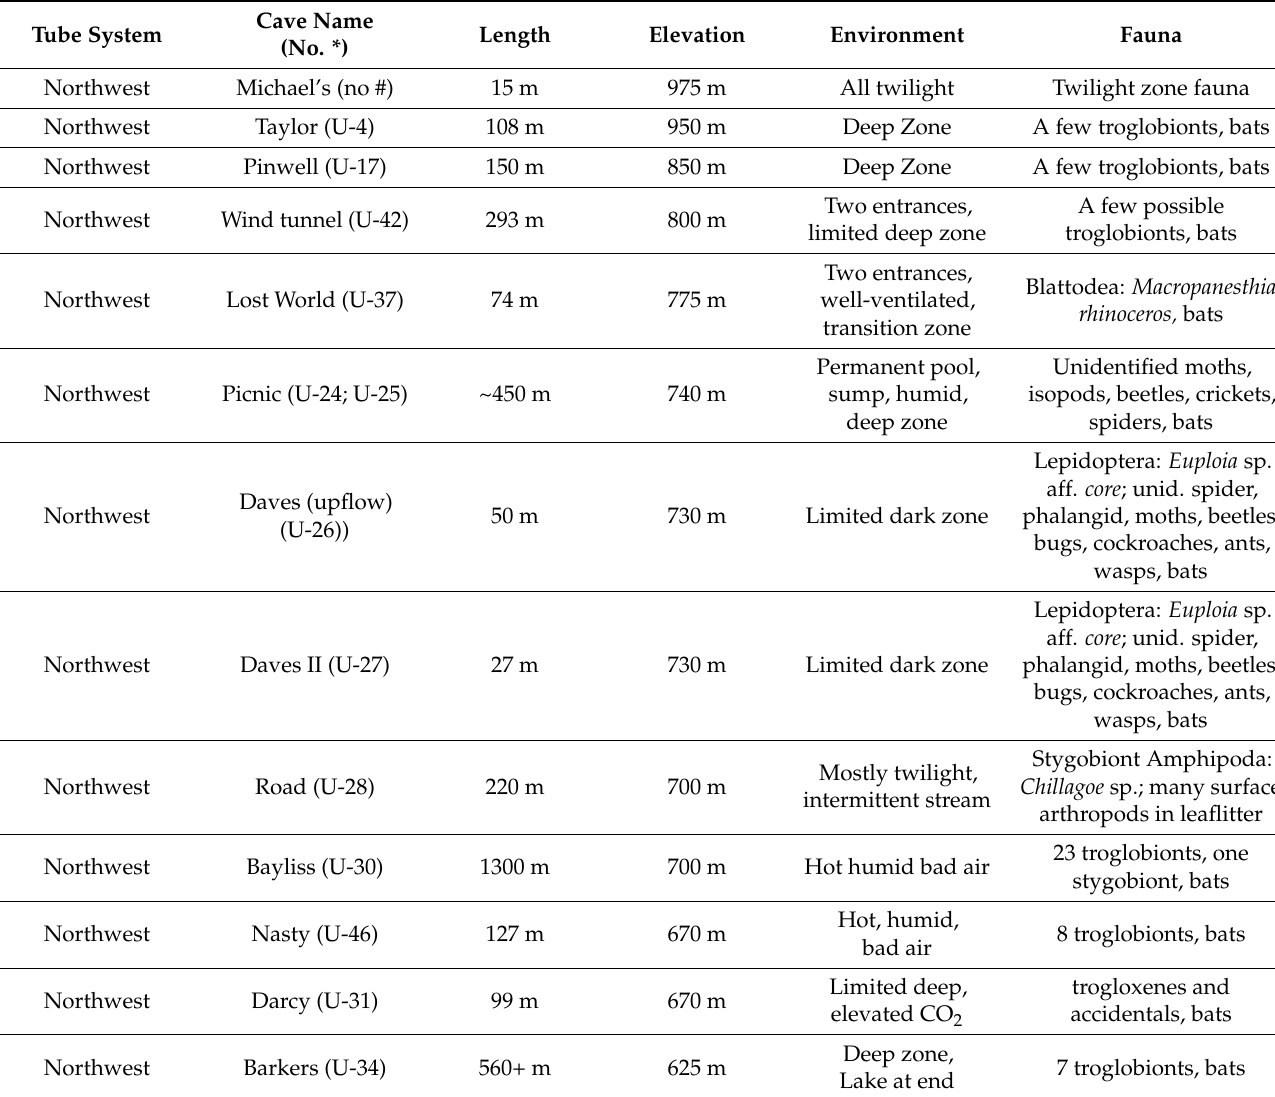
Table 2. Named lava tube segments within the Undara Lava Flow from which cavernicoles have been reported, arranged by tube system, from upslope to downslope. * Indicates cave identification number, Australian Speleological Federation. See also Figure